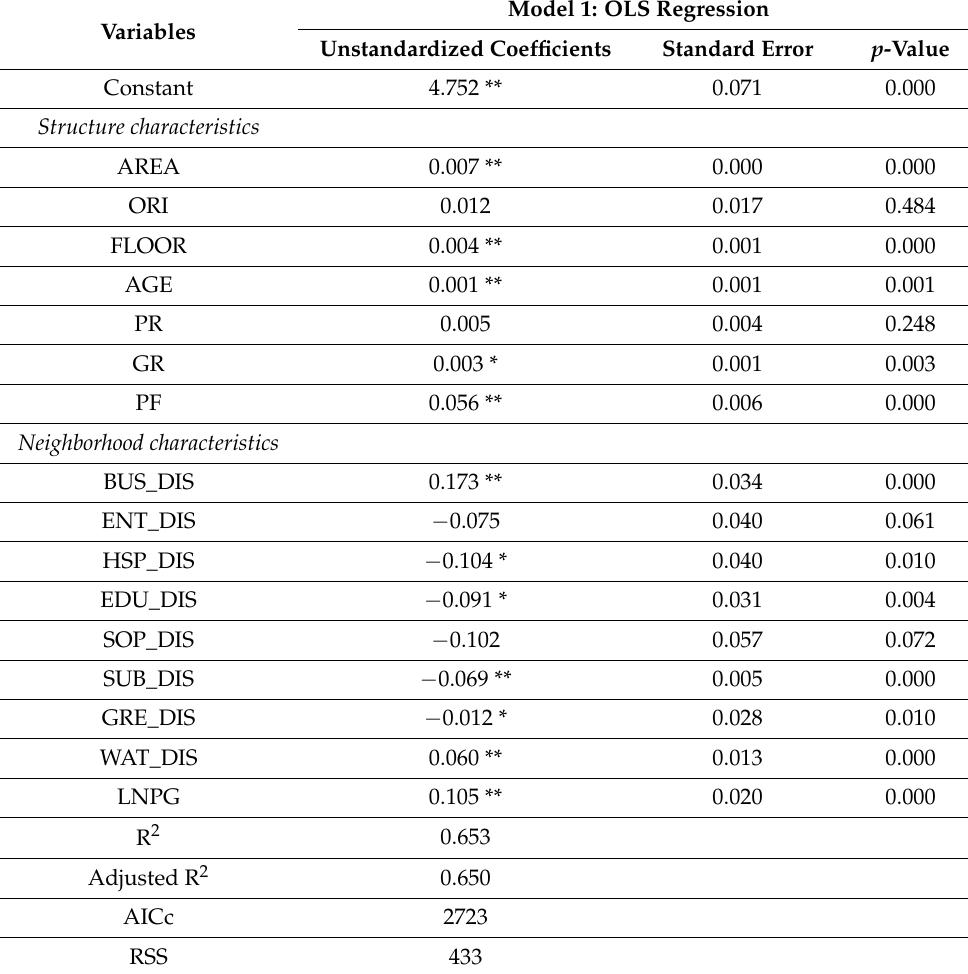
Table 2. Performance of OLS regression ( n = 3175). Model 1: OLS Regression Variables Unstandardized Coefficients Standard